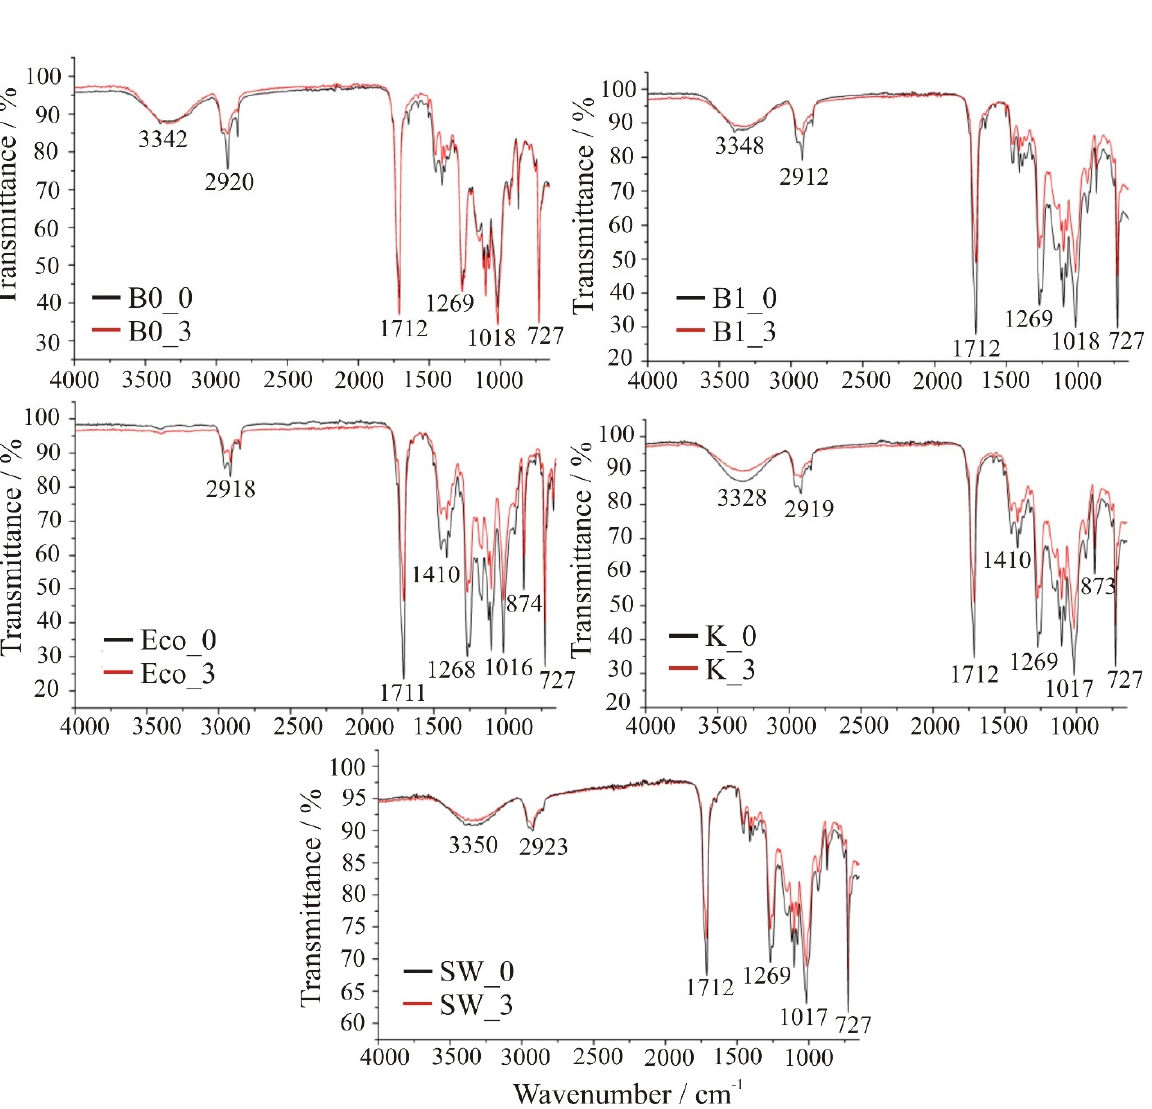
Figure 7. FT-IR spectra of tested samples before and after 3 months of decomposition.